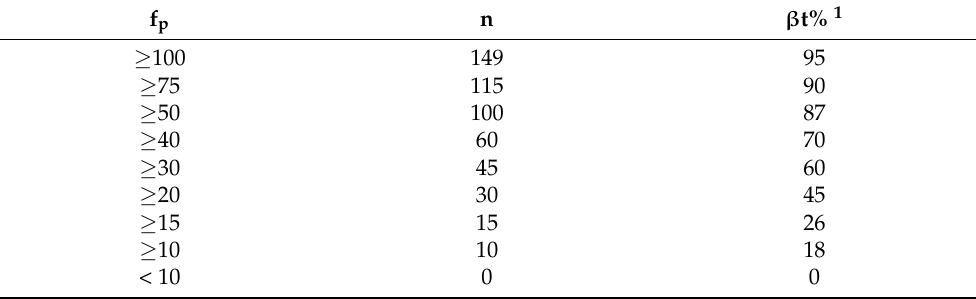
Table 3. Recommended number of samples depending on the calculated weighting factor (f p